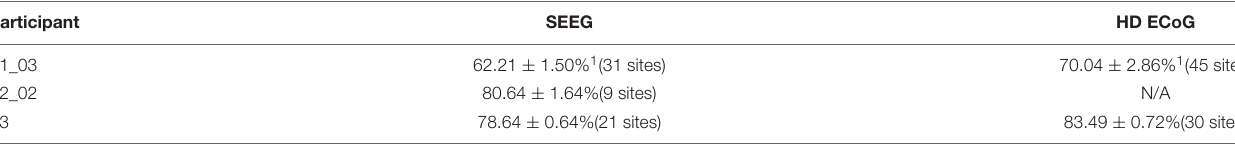
TABLE 2 | Decoding performance (mean ± SD) for tactile stimuli (tapping) applied to thumb, index, and middle finger pads when using a LSTM type recurrent neural network with a feature selection algorithm based on temporal correlation.